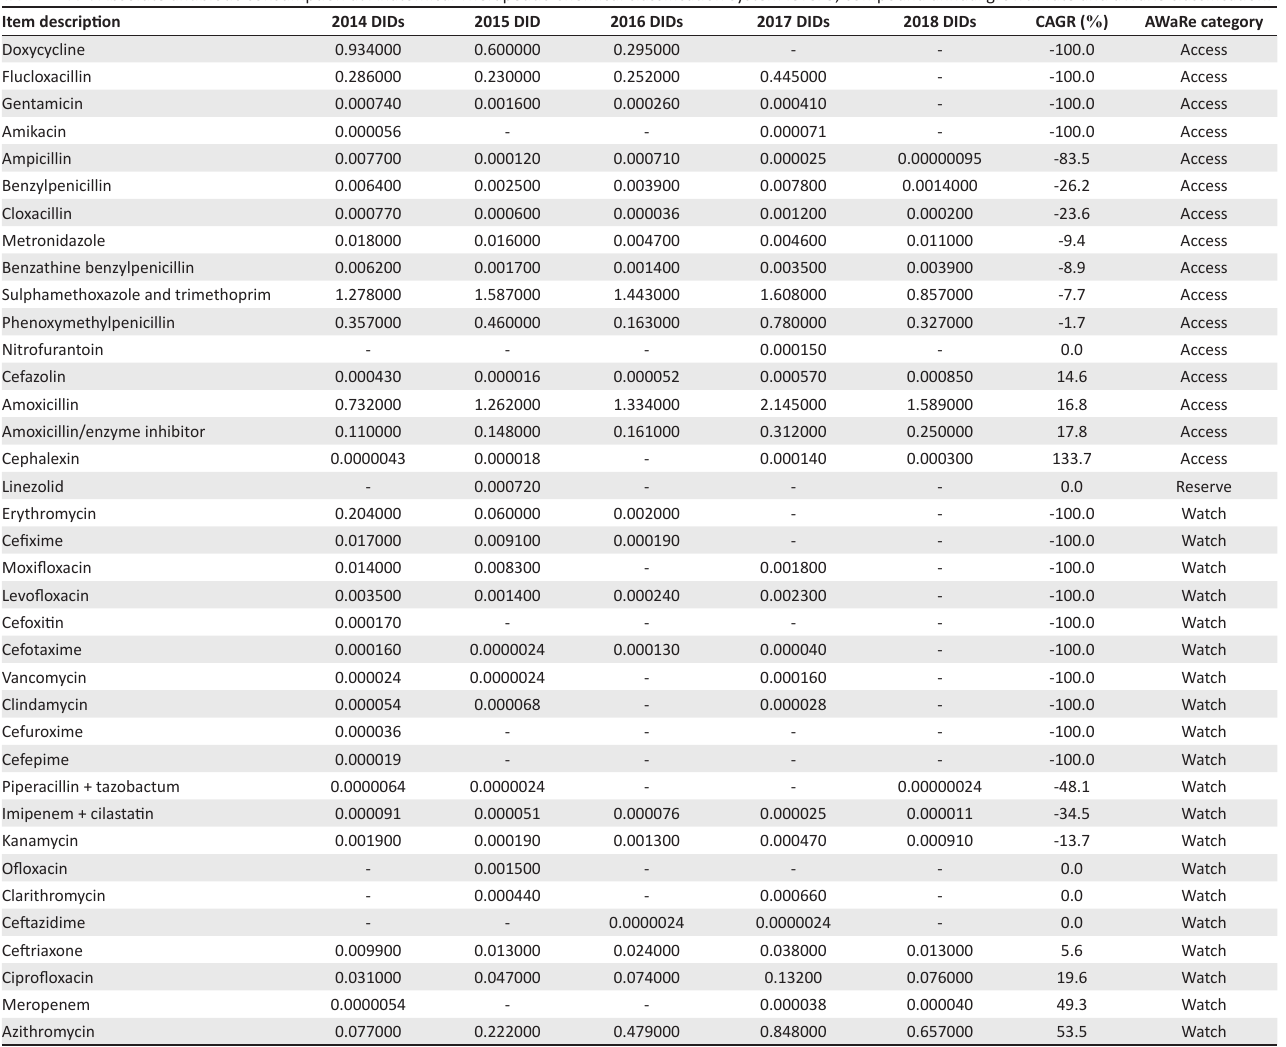
TABLE 1-A1: Absolute antibiotic consumption at Anatomical Therapeutic Chemical classification system level 5, compound annual growth rate and aWaRe